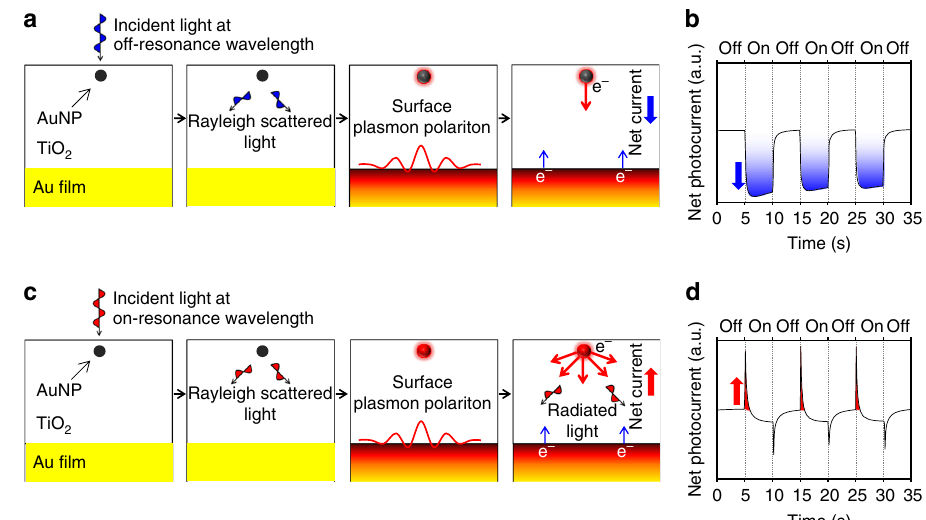
Fig. 2 Generation and interplay of heterogeneous hot electrons in the dual-plasmon device under two characteristic conditions and the corresponding experimental demonstrations. a Au nanoparticle (AuNP) embedded in a TiO 2 layer on top of an Au fi lm, which is illuminated by light whose wavelength is off-resonance with the localized surface plasmon resonance (LSPR) of the AuNP. The incident light is Rayleigh-scattered by the AuNP. The scattered light excites the Au fi lm to generate a random surface plasmon polariton (SPP) at its interface with the TiO 2 layer, which subsequently emits hot electrons via non-radiative plasmon decay. Simultaneously, the AuNP emits a small number of hot electrons by non-radiative plasmon decay. The net photocurrent is negative. b Experimental veri fi cation for the process in a by our typical measurements when the illumination is turned on and off at 600 nm (off-resonance with the LSPR). c Embedded AuNP in a TiO 2 layer on top of an Au fi lm illuminated by light whose wavelength is on-resonance with the LSPR of the AuNP. As in the fi rst case, a random SPP is generated by the scattered light and decays by emitting hot electrons. Simultaneously, the AuNP emits a large number of hot electrons via non-radiative plasmon decay and omnidirectional light via radiative plasmon decay, which also induces the generation of another SPP. The net photocurrent is positive. Here, the direct excitation of hot electrons by the interband or intraband transitions in the Au fi lm is not presented as it is common to two cases. d Experimental veri fi cation for the process in c by our typical measurements when the illumination is turned on and off at 700 nm (on-resonance with the LSPR). See Supplementary Movies 1 and 2 for the animation of the hot-electron interplay and the experimental